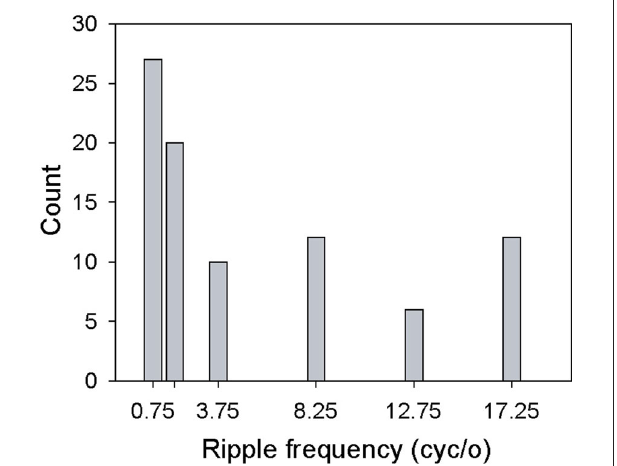
FiGure 5 | Selectivity for ripple frequency. Histogram displays the number of cells whose maximum response (spikes/s) fell at the specified ripple frequency.